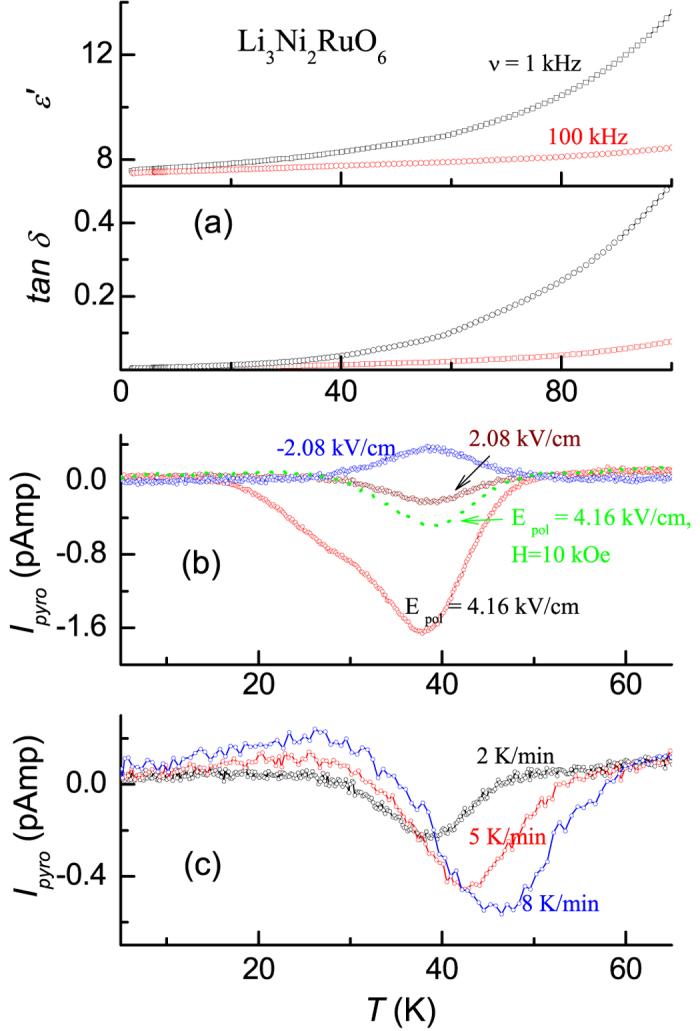
Temperature dependence of (a) dielectric constant (ɛ′) and loss factor (tanδ) shown for two frequencies (1 and 100 kHz), (b) pyroelectric current, Ipyro, for two poling fields, obtained by increasing the temperature at the rate of 2 K/min, and (c) Ipyro as a function of T for different rates of change of T, after poling with 2.08 V/cm, for Li3Ni2RuO6. In (b), the curve obtained in a field of 10 kOe is also included.